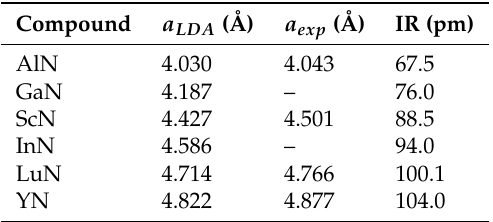
Table 1. Lattice parameters calculated in this work ( a LDA ), available experimental data ( a exp [24–27]) for rock salt nitrides, and ionic (3+) radii of the rare earth and group III elements [28]. Compound